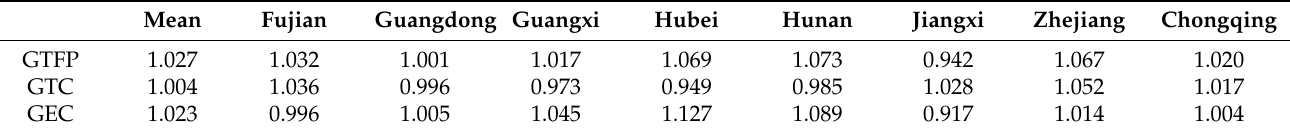
Table 2. Citrus GTFP and its decomposition change by Region.